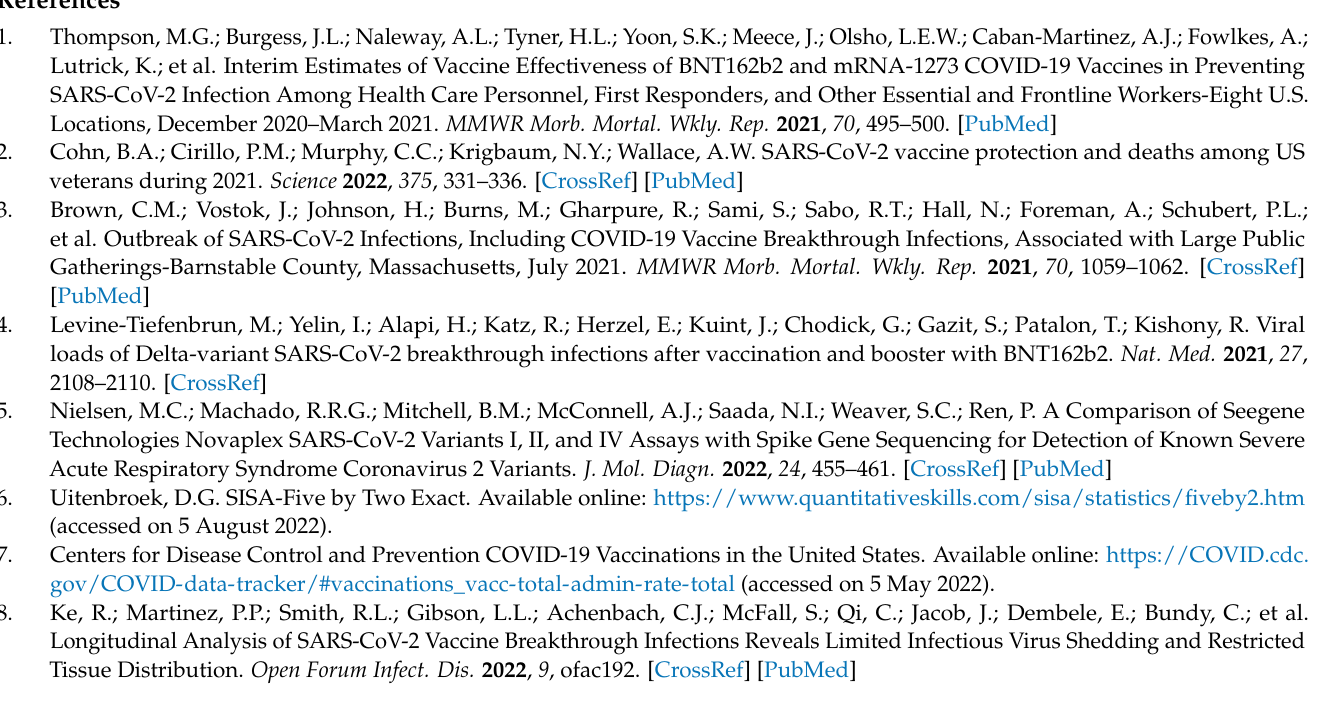
IgA; Figure S2: Impact of Age on Viral Load and IgA; Table S1: Raw